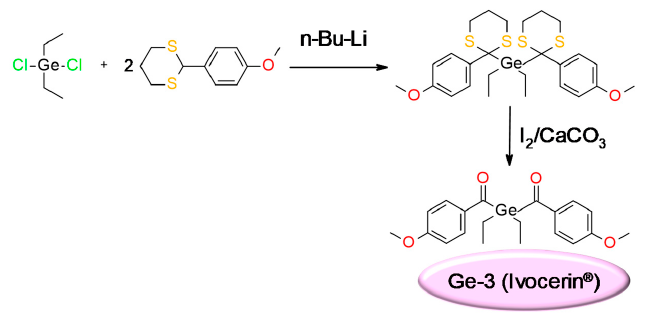
Figure 12. Synthetic pathway to obtain Ivocerin ® product.